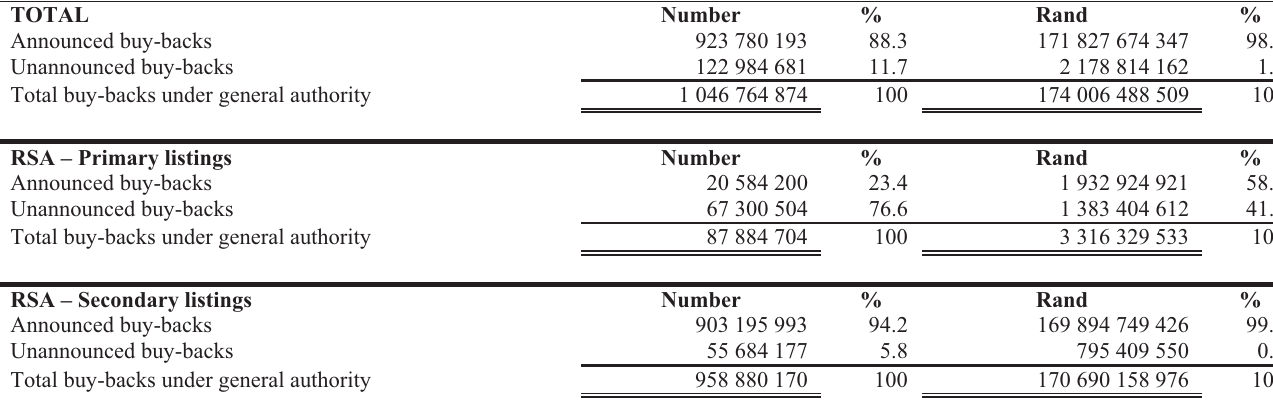
Table 2: Share purchases under general authority TOTAL